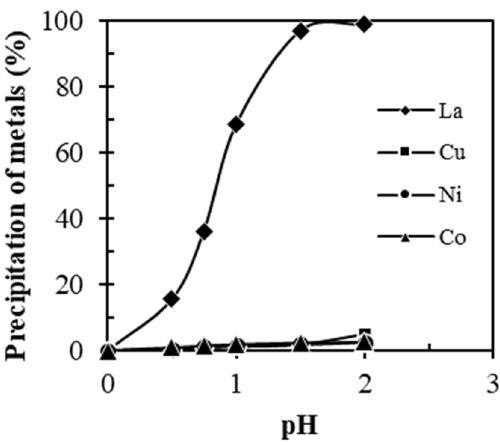
Figure 10. Precipitation of La from leach liquor [Metal concentration in leach liquor (g/L): La: 7.6; Cu: 6.5; Ni: 28.9; Co: 5.1; precipitant: ammonium hydroxide].